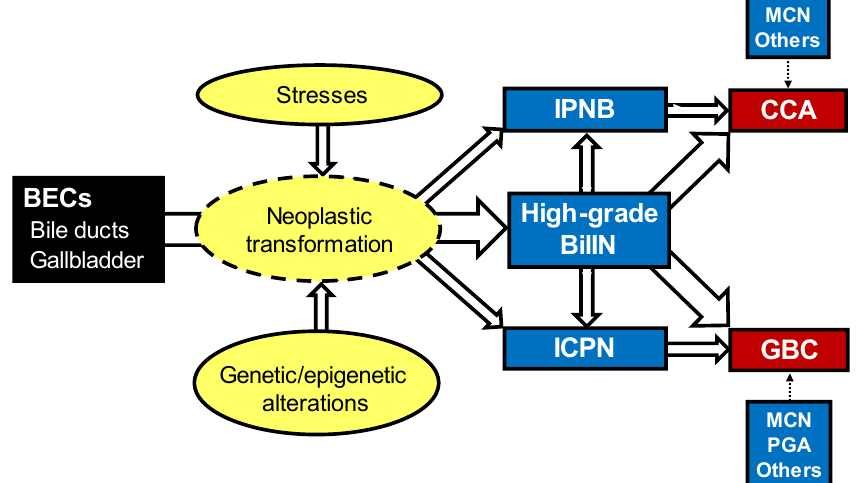
Figure 4. Biliary epithelial cells (BECs) of mucosal lining epithelia and of peribiliary glands (bile ducts) and R-A sinus (gallbladder) undergo neoplastic transformation under environmental stresses and with genetic/epigenetic alterations. As a result, precursor lesions such as intraductal papillary neoplasm (IPNB), high-grade biliary intraepithelial neoplasm (BilIN) and intracholecystic papillary neoplasm (ICPN) develop, and these precursors progress to biliary tract carcinoma: cholangiocarcinoma (CCA) and gallbladder carcinoma (GBC). High-grade BilIN may also relate to the development of IPNB and ICPN. Other precursors such as mucinous cystic neoplasm (MCN) and pyloric gland adenoma (PGA) play a minor role in the development of CCA and GBC.